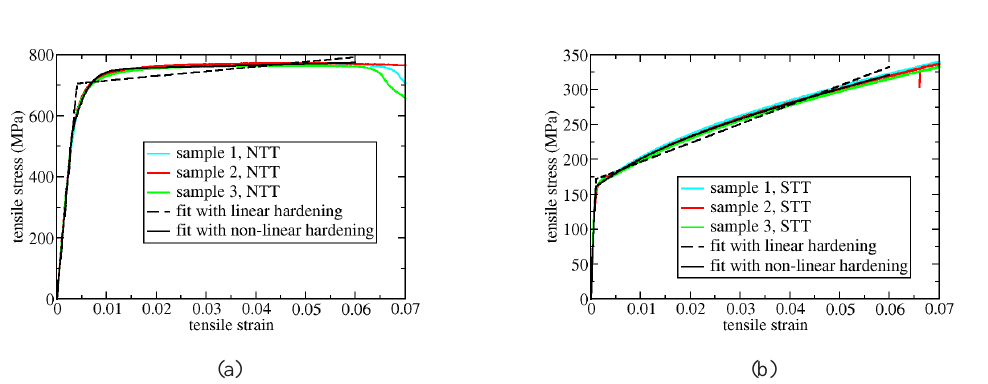
Fig. 2. Stress vs. strain curves resulting from the tensile tests performed on the tubes a) non-treated b) submitted to the treatment STT. The fitted behaviours, with both the linear and the non-linear hardening, are plotted in the figures. Similar curves have been obtained for the thermal treatment LTT.